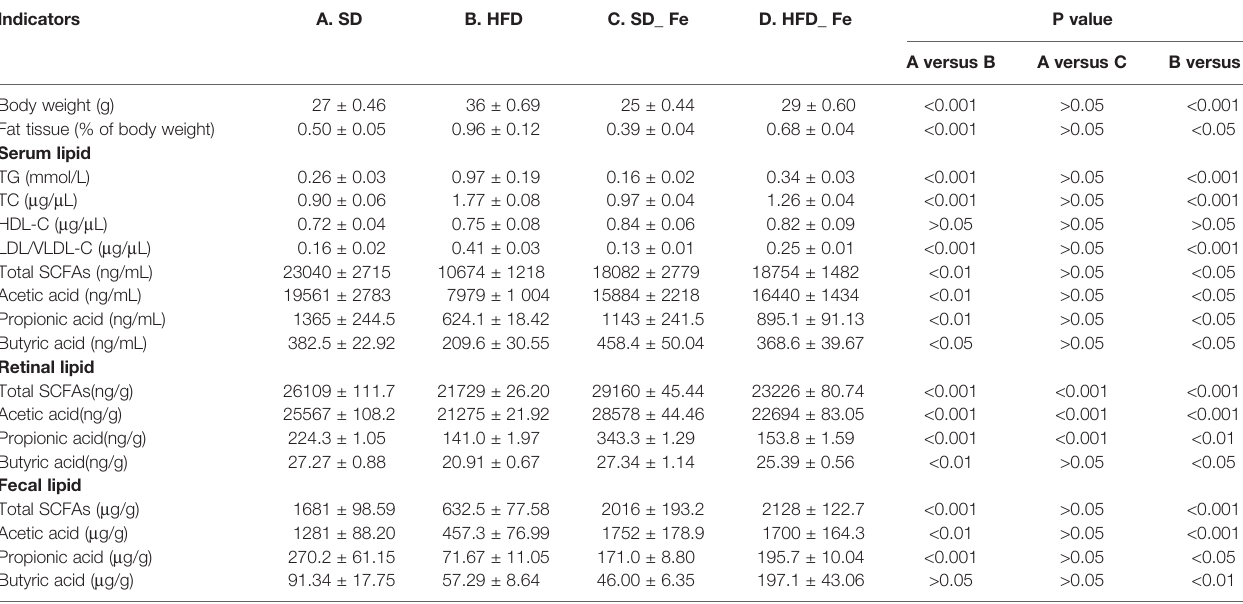
TABLE 1 | Fat/lipid levels in serum, retina and feces. Indicators